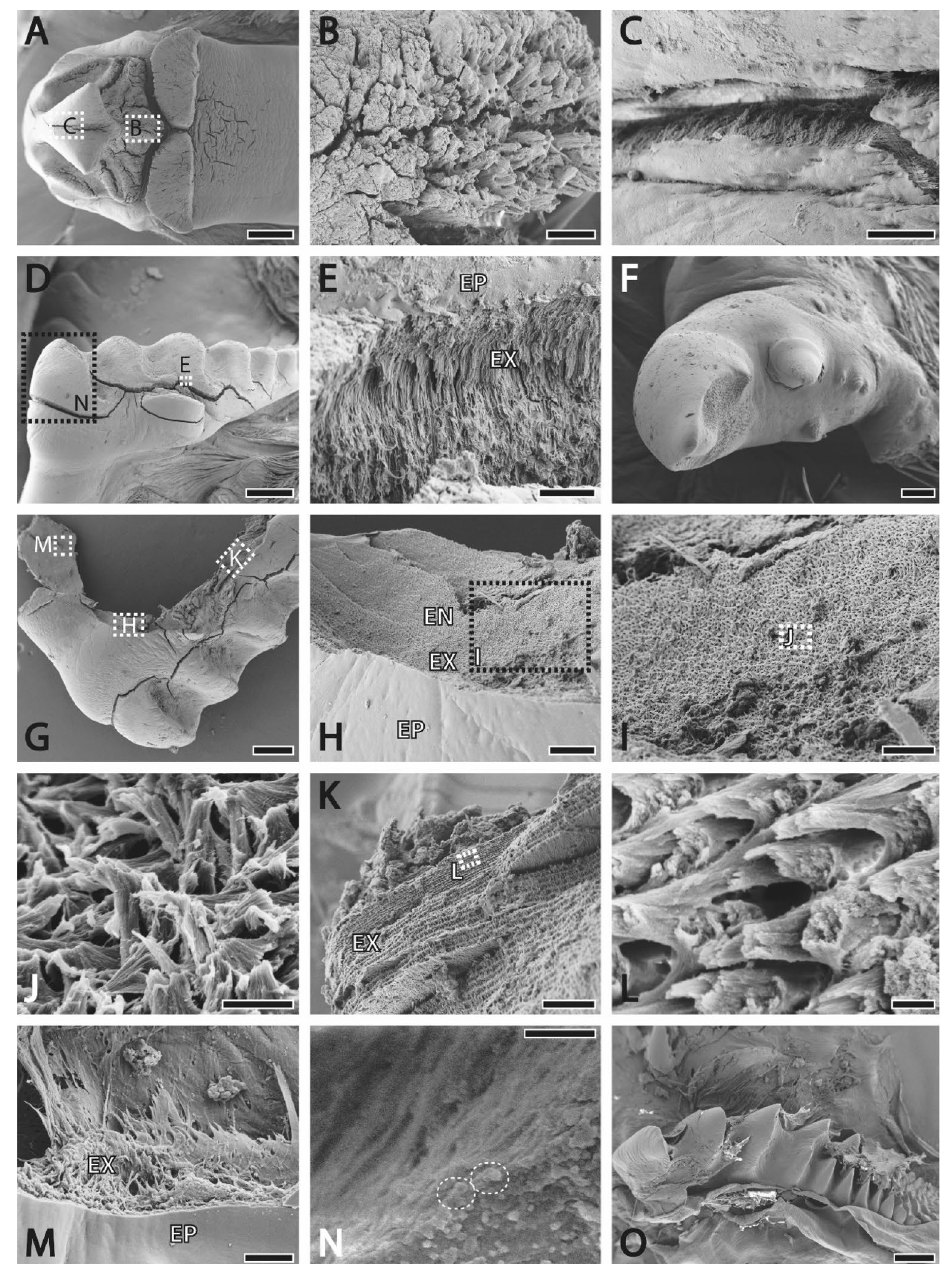
Figure 2. SEM images. ( A )–( C ) Medial tooth with magnifications of the tooth surface ( B – C ). ( D )–( E ) Lateral tooth and its fracture at high magnification ( E ) of the epicuticle and the fibrous exocuticle. ( F ) Accessory tooth. ( G )–( M ) Chitin fiber structure of the lateral tooth basis. ( J ) Fibers are bend helically. ( K )–( L ) Layered structure of the exocuticle at low and high magnifications ( L ). M. Chitin fiber orientation in the exocuticle. ( N ) Fractured medial tooth with potential fracture artefacts between fibers. ( O ) Immature lateral tooth. EN endocuticle, EP epicuticle, EX exocuticle. Scale bars: A, 800 µm; B–C, H, 30 µm; D, 600 µm; E, I, 20 µm; F, 100 µm; G, 400 µm; J, 2 µm; K, 30 µm; L, 600 nm; M, 10 µm; N, 1 µm; O, 400